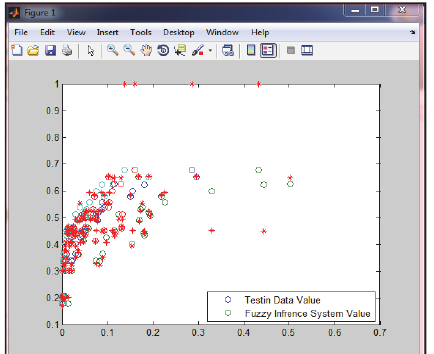
Fig. 8. Displaying real values and the values calculated by the insurance or underwriting risk